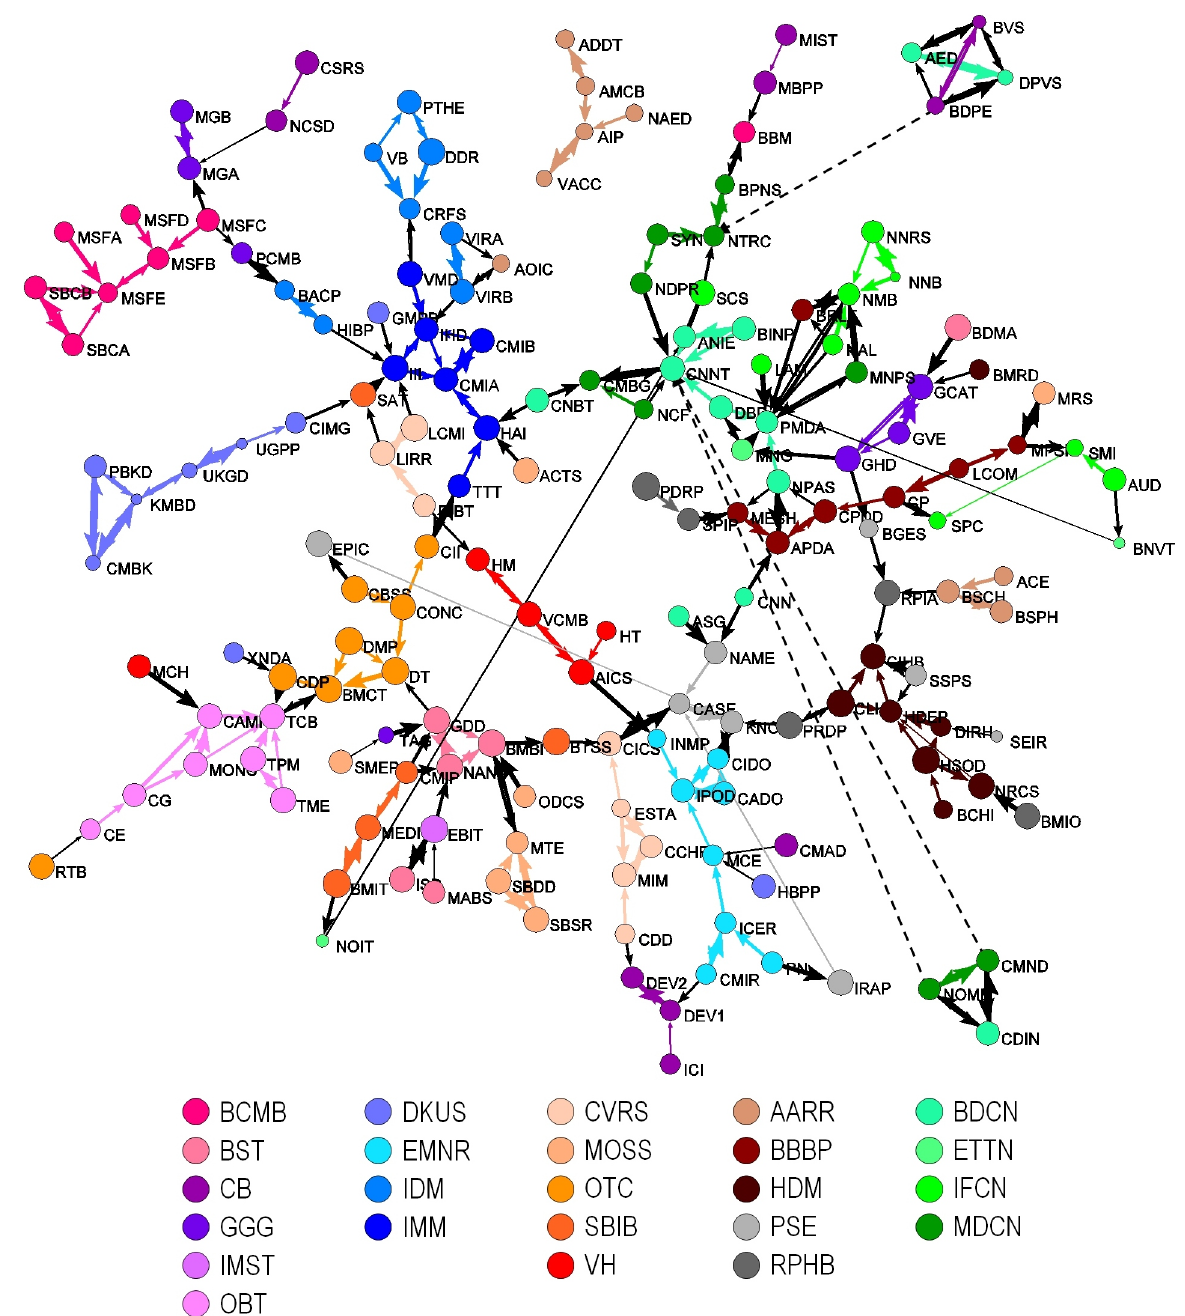
Figure 3. Consensus study section network. Study section names for each acronym are available in Appendix S2. Edge width corresponds to rank – the thickest edges represent rank=1, etc. Edges between study sections in the same IRG are colored with the IRG color. Edges between study sections in different IRGs are colored black. Dashed lines indicate where the smaller components connect to the main component, but with lower ranked